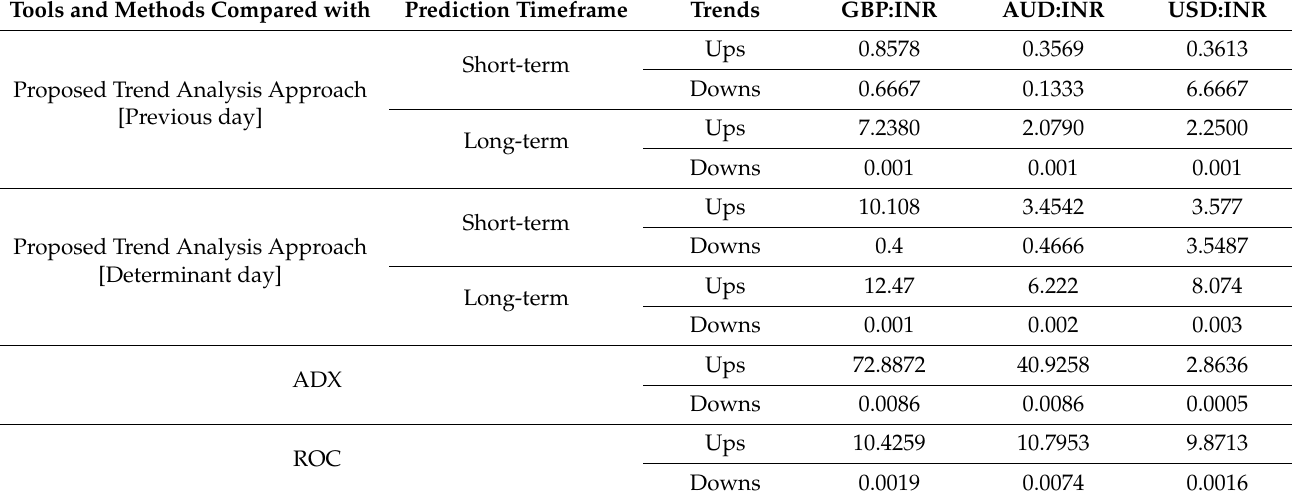
Table 10. Maximum units up and down (return results) observed for three currency